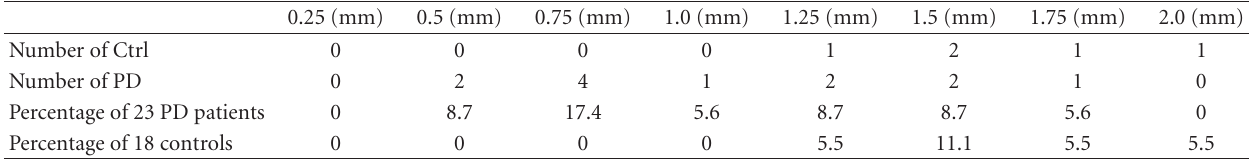
Table 3: Individual subjects outside their group’s retinal thickness mean IOD at 1.5 control SD at each radial distance (mm).